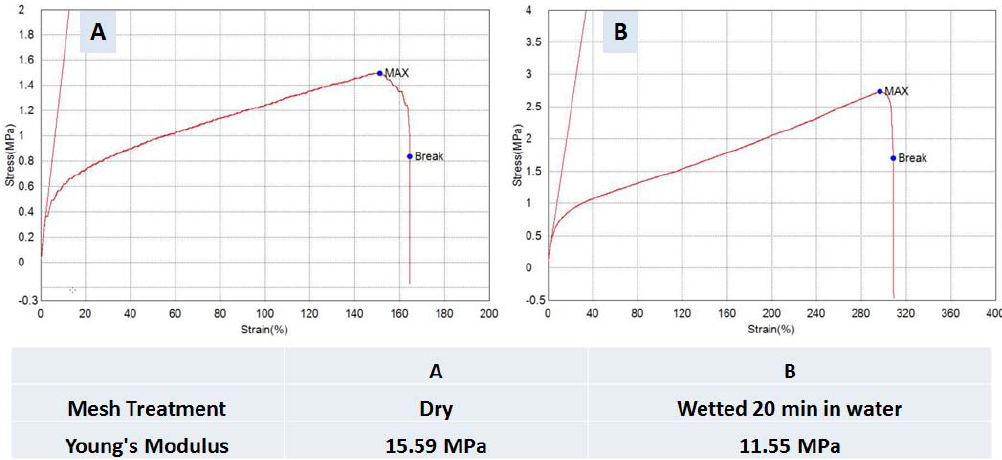
Figure 2. ( A ) Tensile strength graph of a dry PCL nanofiber mesh; ( B ) Tensile strength graph of a wet PCL nanofiber mesh, which is soaked in water for 20 min. The elastic modulus values are listed in the table in the figure, showing 15.59 MPa for the dry and 11.55 MPa for the wet